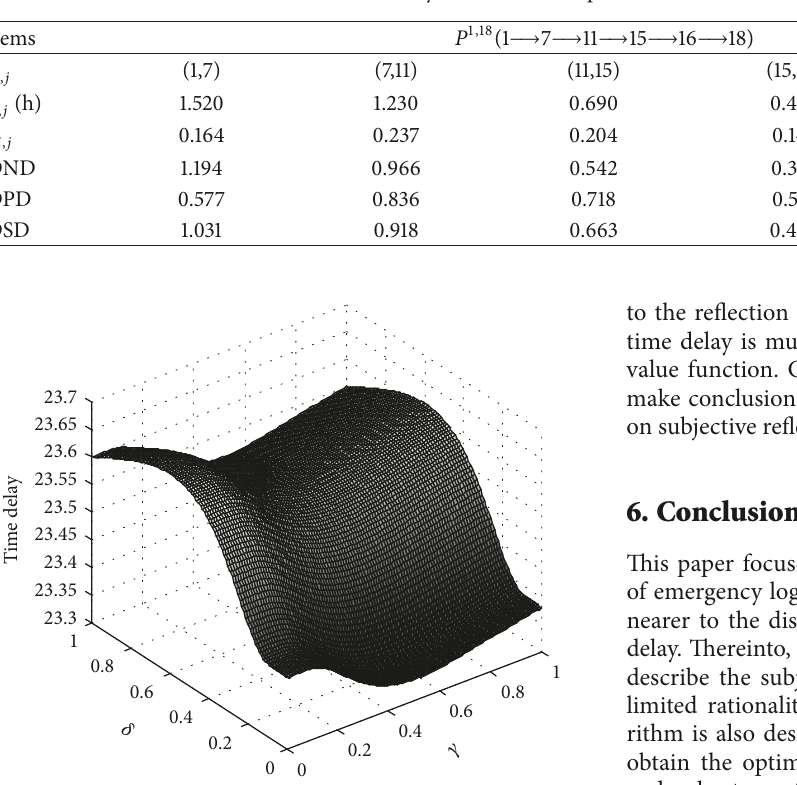
Table 6: The time delay of P 1,18 with the poorer timeliness and the poorer robustness.